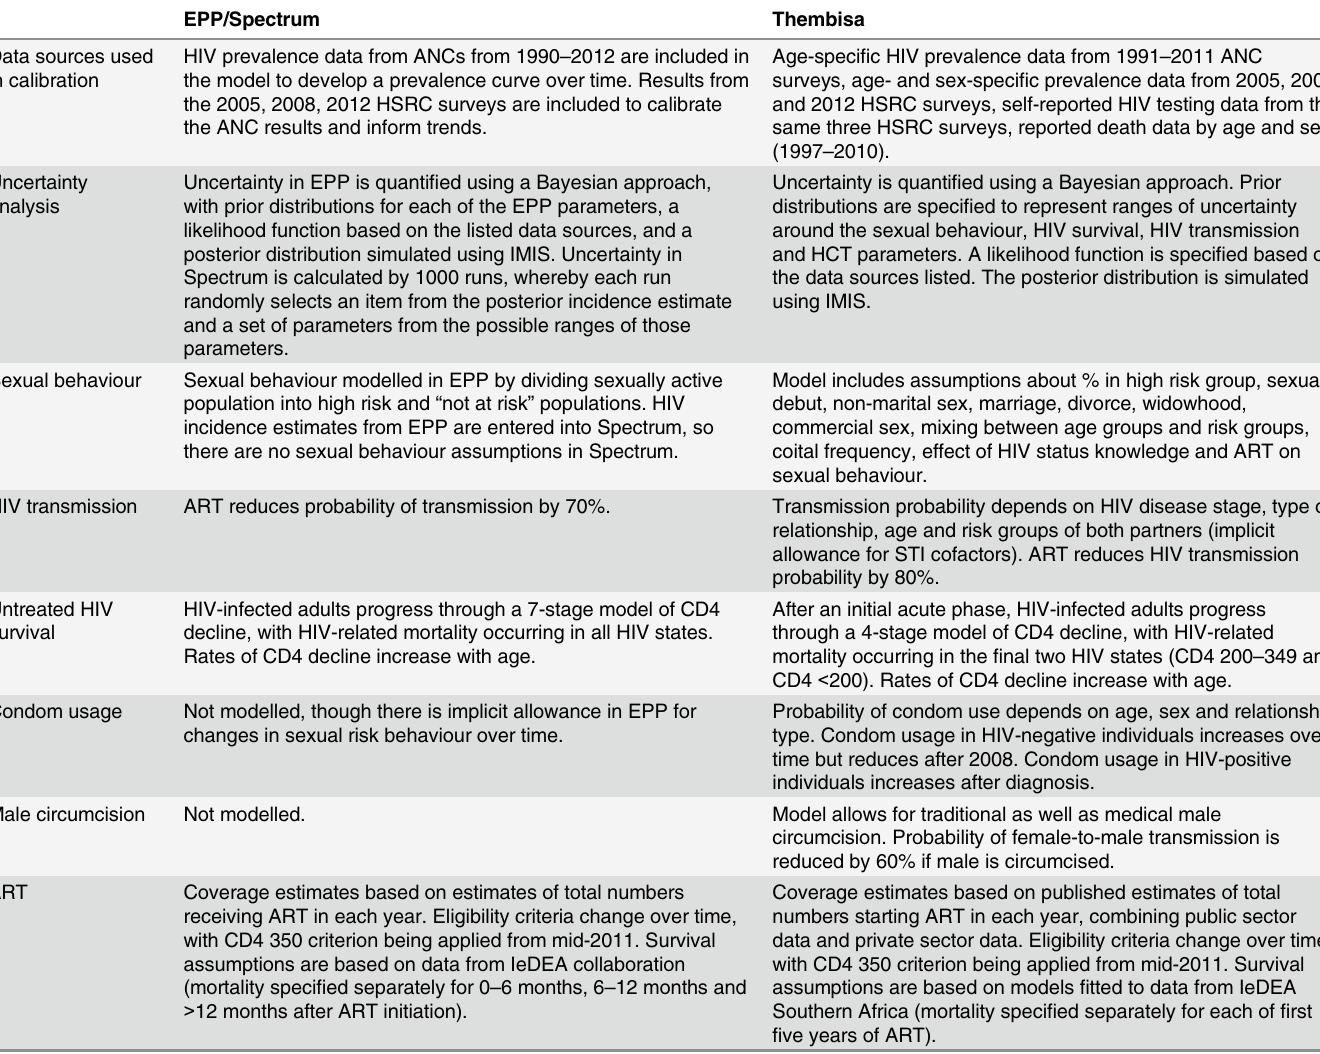
Table 1. Comparison of EPP/Spectrum and Thembisa: Model inputs and assumptions for adult HIV incidence estimation. EPP/Spectrum